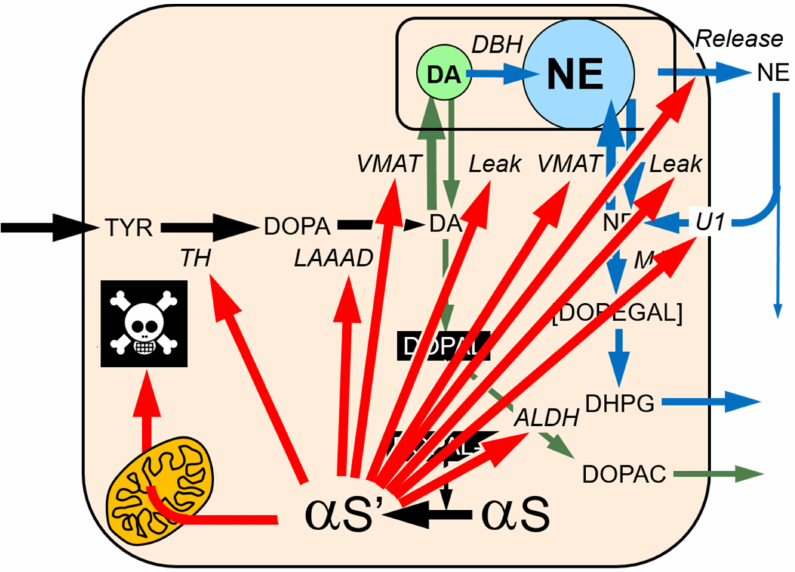
Figure 6. Some effects of 3,4-dihydroxyphenylacetaldehyde (DOPAL)-induced modification of alpha- synuclein ( α S). Among myriad protein modifications exerted by DOPAL, one of the most prominent is oligomerization of, formation of quinone–protein adducts with (“quinonization”), and aggregation of α S. DOPAL-induced α S oligomers interfere with vesicular functions and are toxic to mitochondria. Not shown, α S may increase DOPAL formation via stimulation of MAO activity. The relative roles of DOPAL alone, α S alone, and their interactions in catecholaminergic neurodegeneration is poorly understood. It is also possible that α S and DOPAL emanating from catecholaminergic neurons can be taken up into non-neuronal glial cells and harm the neurons indirectly via altered glial